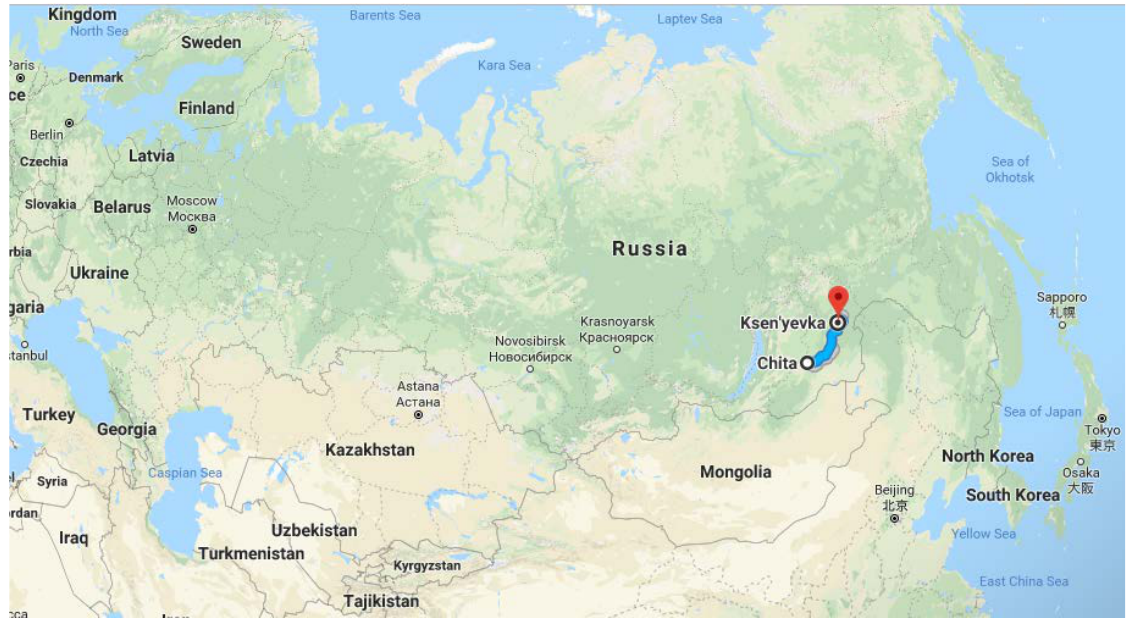
Figure 1. Ksenyevka's location on the map of the Russian Federation studies in Russia are based on urban populations because of easier access to the participants. This bias of focusing on urban populations, may underestimate the burden of CVD and their risk factors in rural Russia, where only a few studies have been conducted. Therefore, studies focusing on the morbidity and mortality of rural population in Russia are needed to fill this important research